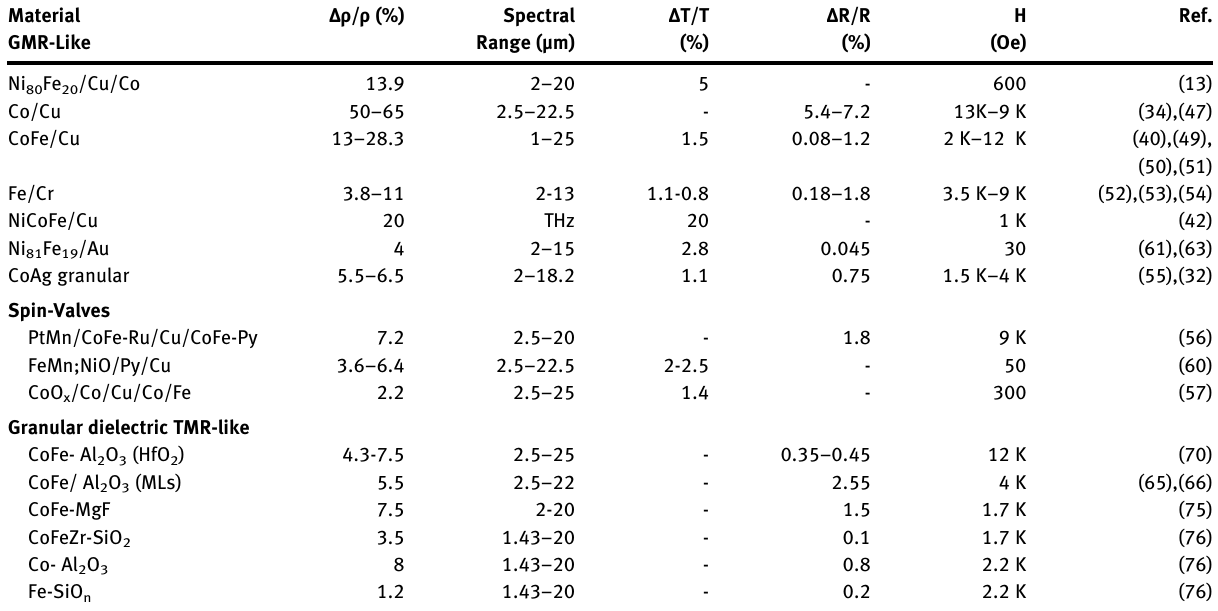
Table  : MRE intensities in a variety of spintronic structures: Columns from left to right: Type and composition of the structures. Repre- sentativevaluesof themagnetic fi eldinducedchangesofthe electricalresistivity. Spectrarangeof theopticalmeasurements.Absolutevalue of the maximum of the MRE spectra in transmission ( Δ T/T) or re fl ection ( Δ R/R). Characteristic magnetic fi elds at which the MRE spectra were